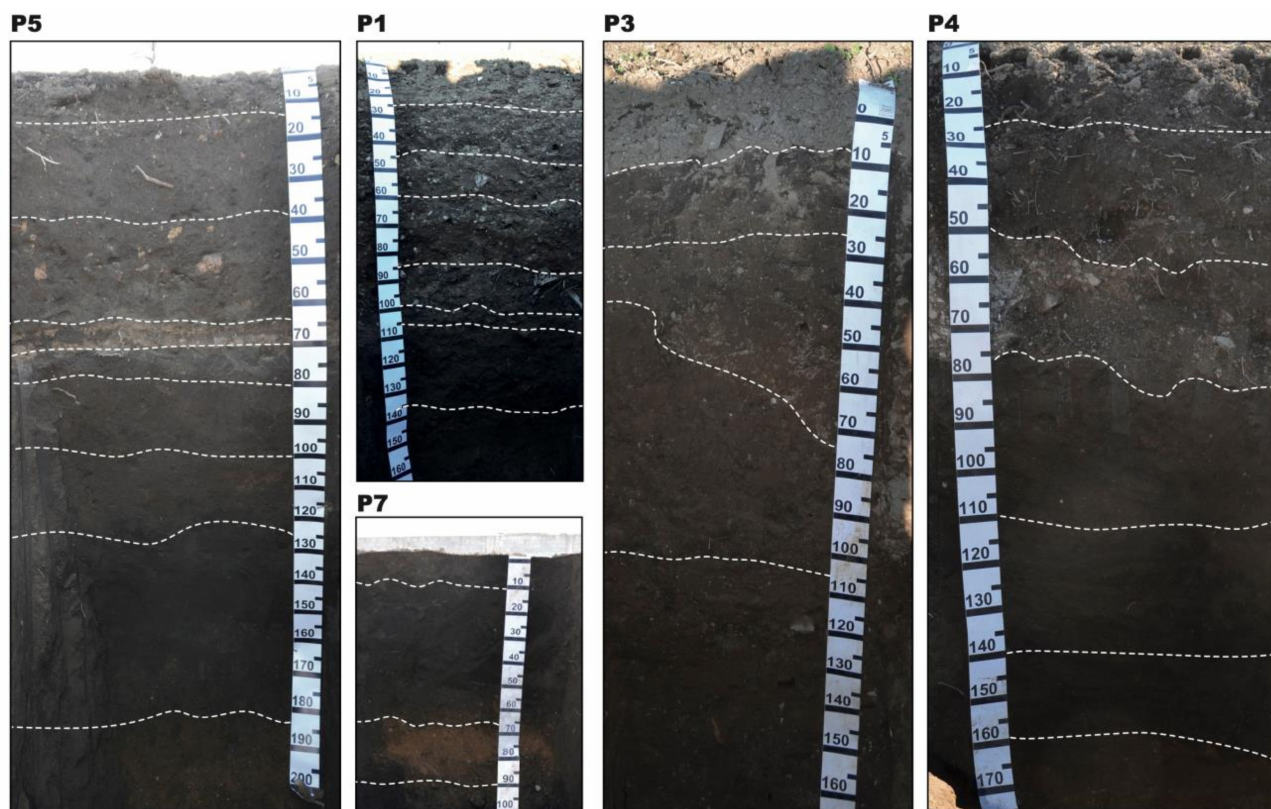
Figure 6. Soil profiles characterizing HZ1 and HZ2 in site 1 ( P1 and P3 , respectively), and HZ3, HZ4a and HZ4b in site 2 ( P4 , P5 , and P7